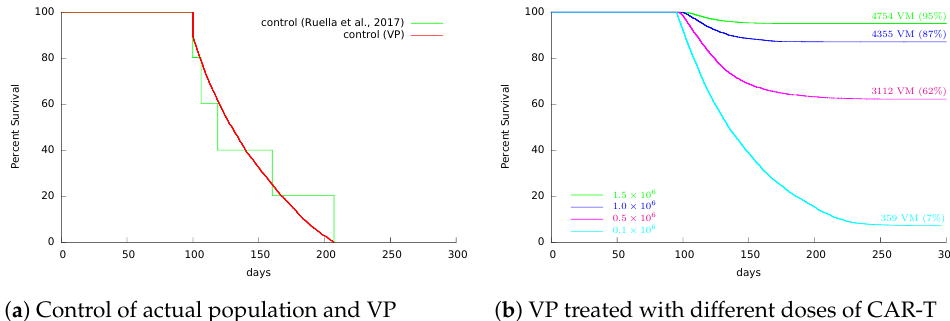
Figure 6. Kaplan–Meier survival curves over 300 days. ( a ) Experimental data from [7] (green) and VP of mice engrafted with HDLM-2 tumor (red). ( b ) CAR-T dose of 1.5 10 6 cells led to 95% overall × survival in almost one year, 5% lower than those observed in [7] owing to individual parameter uncertainties. Overall survival decreased significantly with dose reduction. Specifically, the survival rate reached 7% when the dose decreased to 1.0 10 5 CAR-T cells. The number of VM that survived × for 300 days for each dosing strategy is also